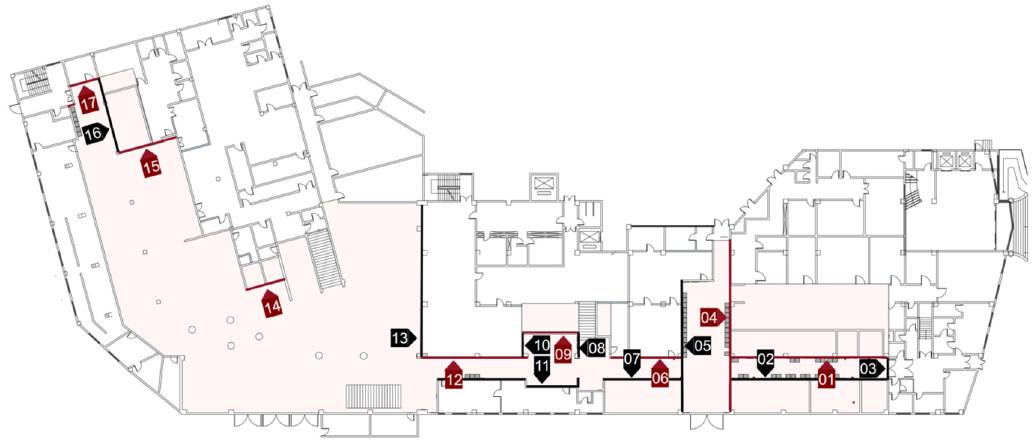
Figure 11. ED floor plan with interior elevation mark (Interior elevation marks range from 01 to 17).